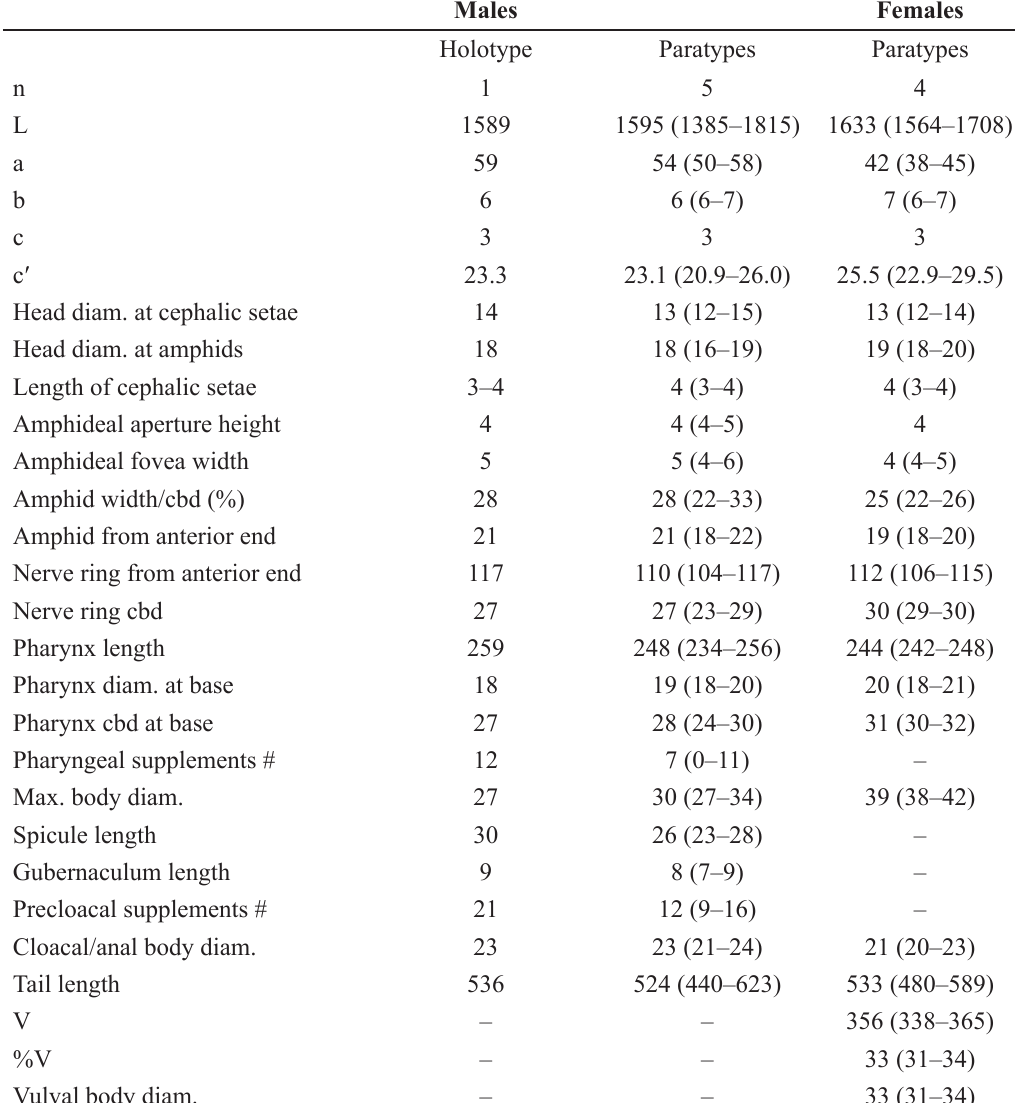
Table 2. Morphometrics (μm; mean (range)) of Halanonchus scintillatulus Leduc sp. nov. from Hauraki Gulf. Abbreviations see Material and